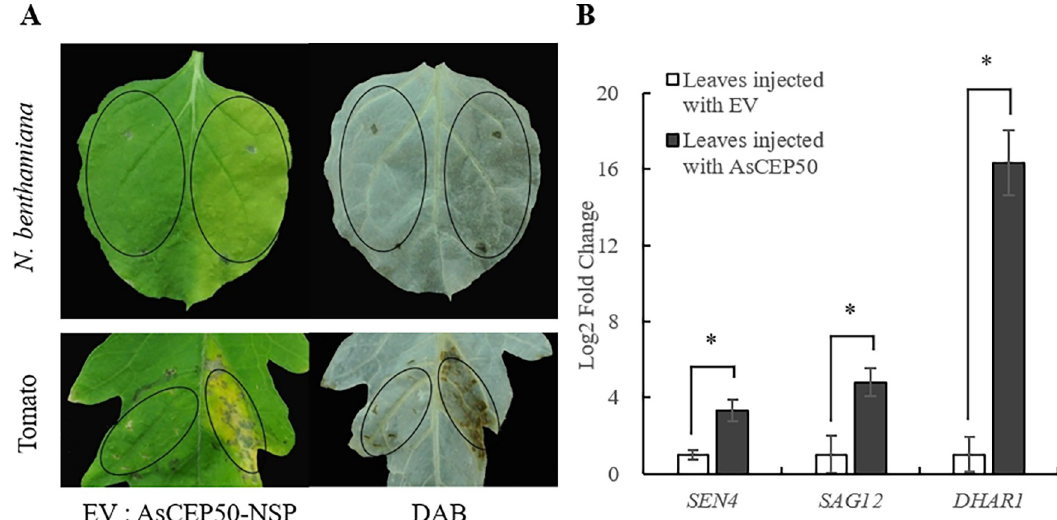
Fig 3. Agrobacterium containing AsCEP50 effector promotes senescence of N . bethamiana and tomato leaves. ( A ) Nicotiana benthamiana and tomato leaves were infiltrated by control (EV; left, leaf tip to petiole direction) and pCAMBIA1301 Agrobacterium containing AsCEP50 -NSP gene (right, leaf tip to petiole direction). ( B ) Relative mRNA levels of SEN4 , SAG12 and DHAR1 . Expression levels of senescence- and oxidative stress-associated genes were examined in N . benthamiana (EV and AsCEP50 -NSP) 4 days after injection with Agrobacterium .